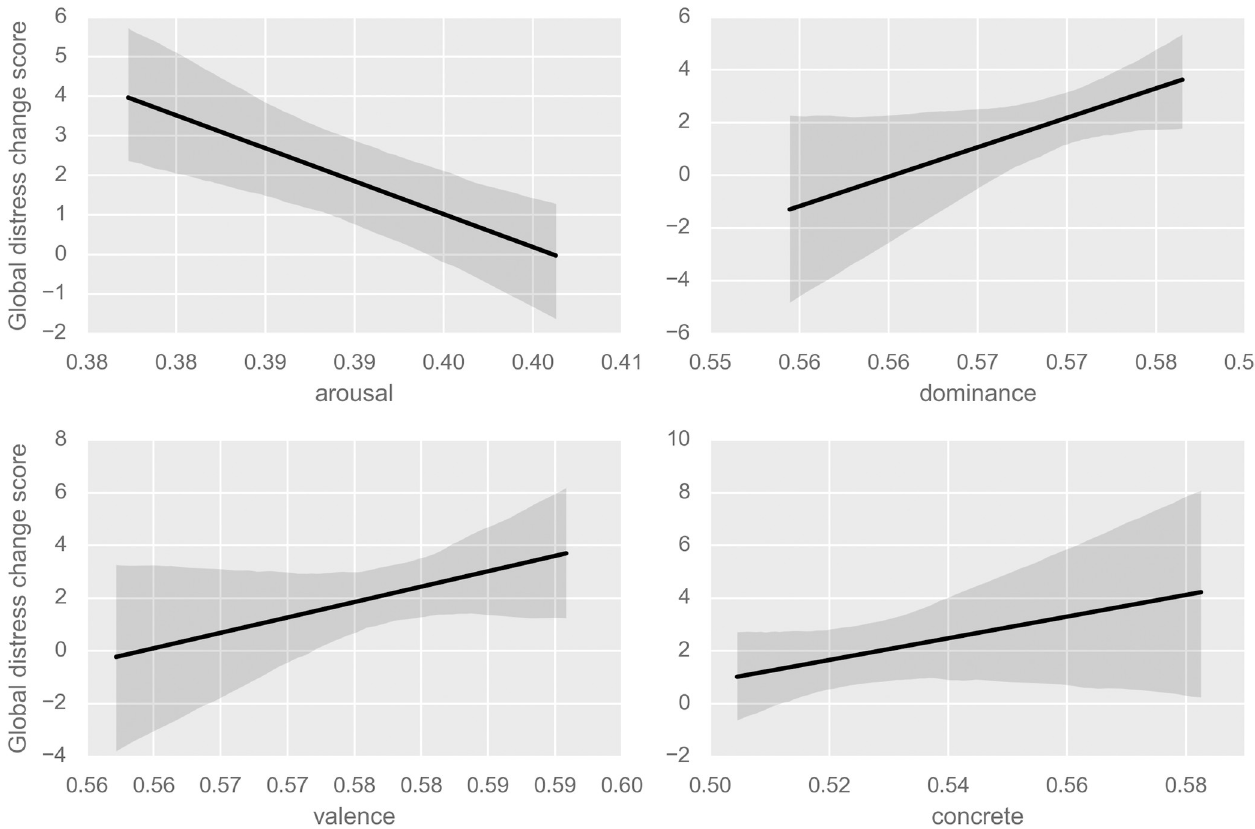
Fig 4. Effects of arousal, dominance, valence, and concreteness on global distress change score in Study 1.